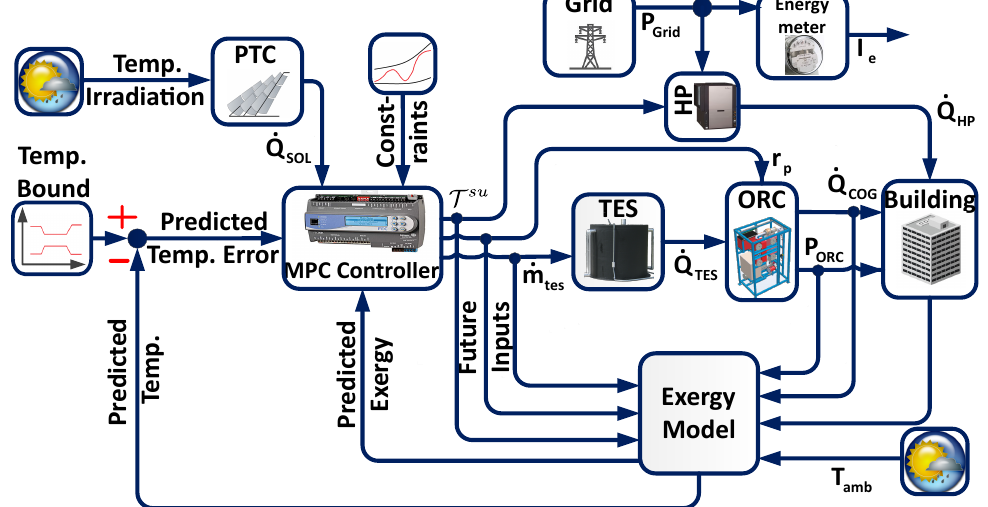
Figure 16. Structure of the exergy-based MPC for the combined MicroCSP and building HVAC system. (Reprinted from [21] with permission of